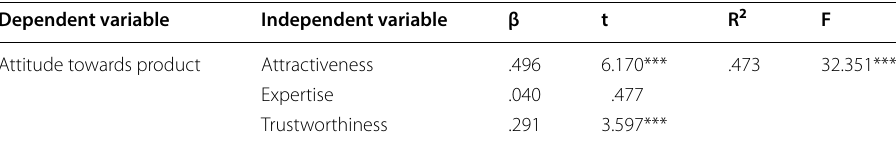
Table 13 Multiple regression result of vlogger’s attributes on attitude towards products— explicit exposure